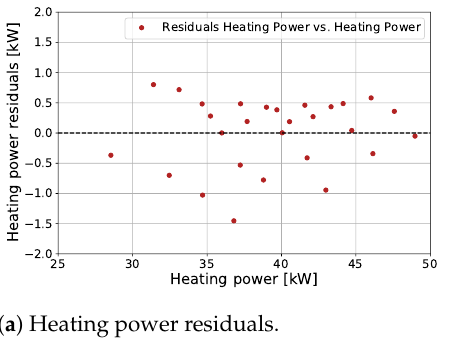
Figure 1. Residuals from the Heat Pump (HP)